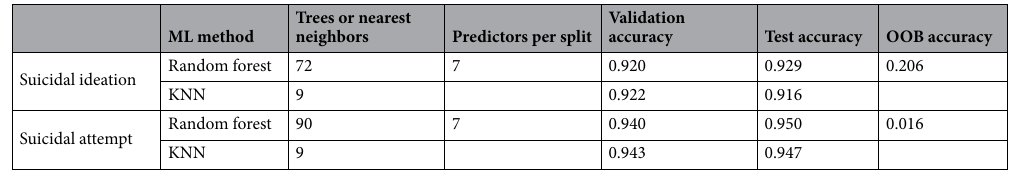
Table 2. Accuracy by ML methods. The Random Forest models are optimized with respect to the out-of-bag accuracy. The kNN models are optimized with respect to the validation set accuracy.